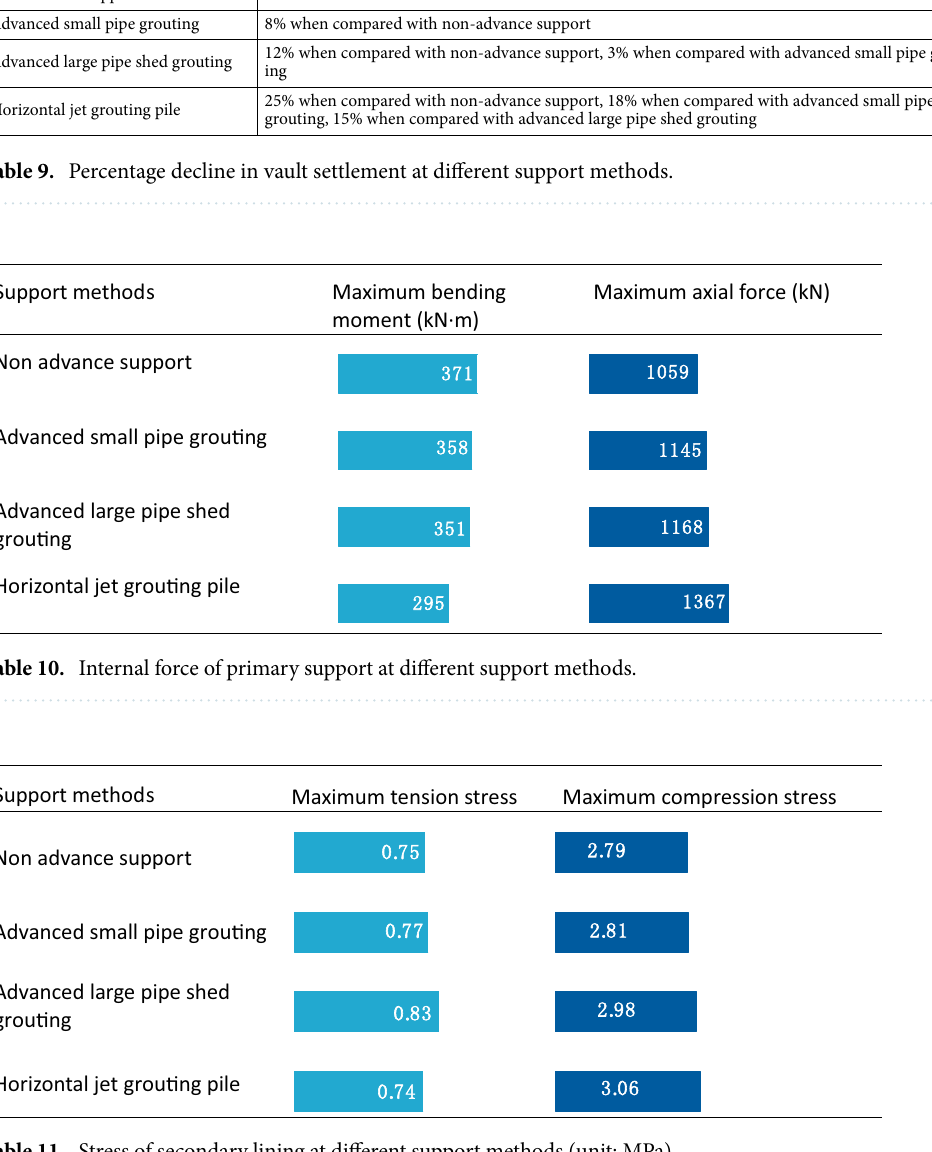
Table 11. Stress of secondary lining at different support methods (unit: